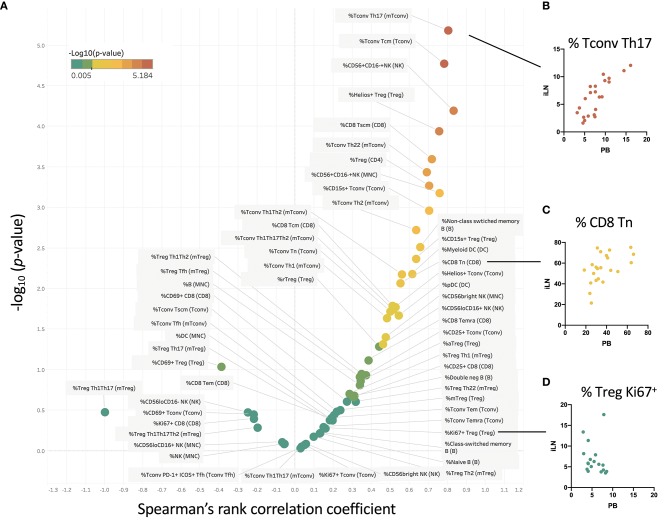
Some cell populations show strong correlation between frequency in blood and iLN, others show no correlation. (A) Within individual correlation of cell population frequencies between blood and iLN was calculated using data from all individuals by Spearman's rank correlation. Points are colored based on p-values with those showing significant correlation (p < 0.05) shown in yellow-red symbols and those with no significant correlation shown in shades of green. (B–D) Example correlation for individual cell subsets showing a high (B), medium (C), and no significant correlation (D) between frequencies in the blood and iLN.